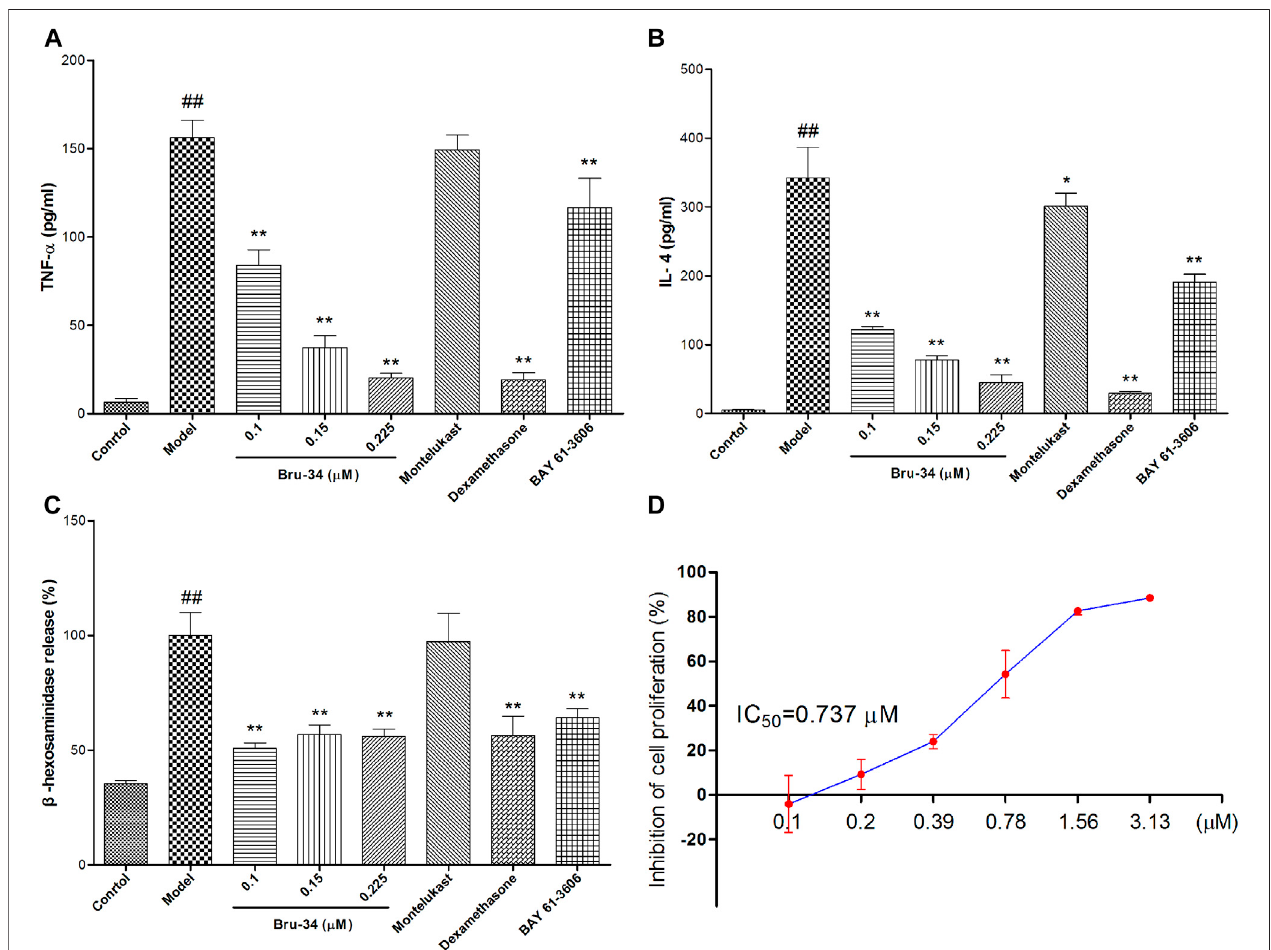
FIGURE 5 | Bru-34 attenuated IgE antigen-induced in fl ammation in RBL-2H3 cells. Panel (A) : The level of TNF- α in cell culture supernatant; Panel (B) : The level of IL-4 in cell culture supernatant; Panel (C) : The release of β -hexosaminidase in cell culture supernatant; Panel (D) : The inhibition of cell proliferation; Data were given as mean ± S.D. n (cid:2)